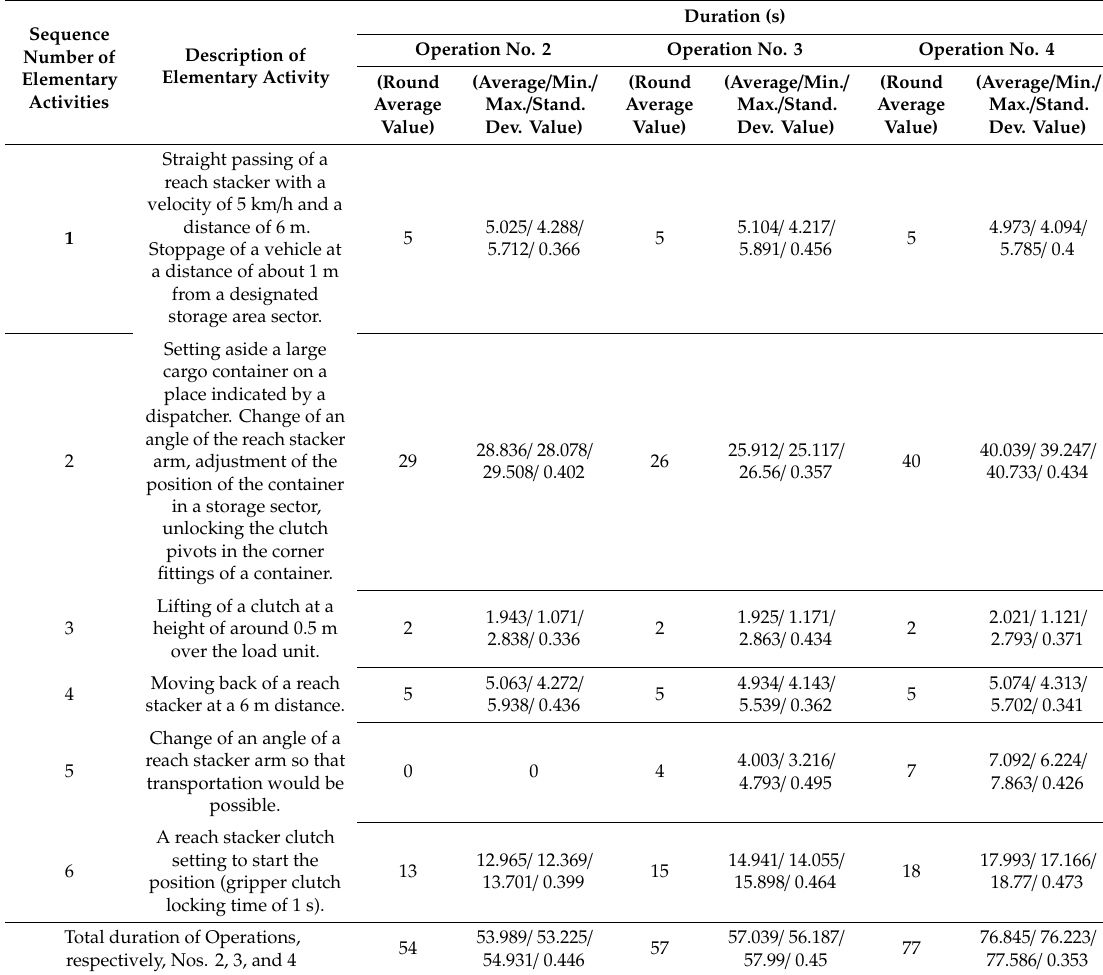
Table 2. Description of the elementary activities, which are part of Operations Nos. 2–4. Source: own